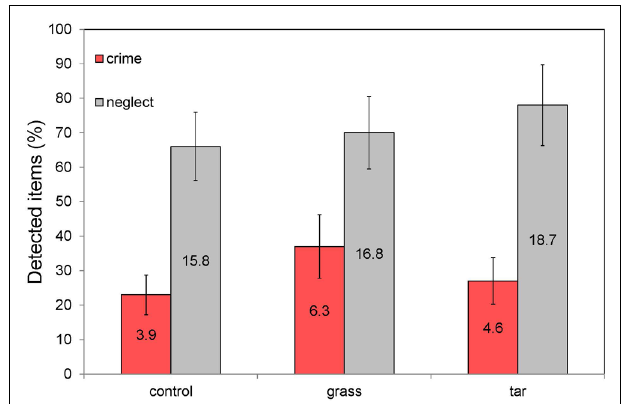
FIGURE 2 | Percentage of detected items signaling Neglect (a total of 24 items) and Crime (a total of 17 items) in each of the three experimental ambient scent conditions (no odor, grass odor, tar odor). The labels inside the bars represent the mean number of detected items. The error bars represent the standard error in the